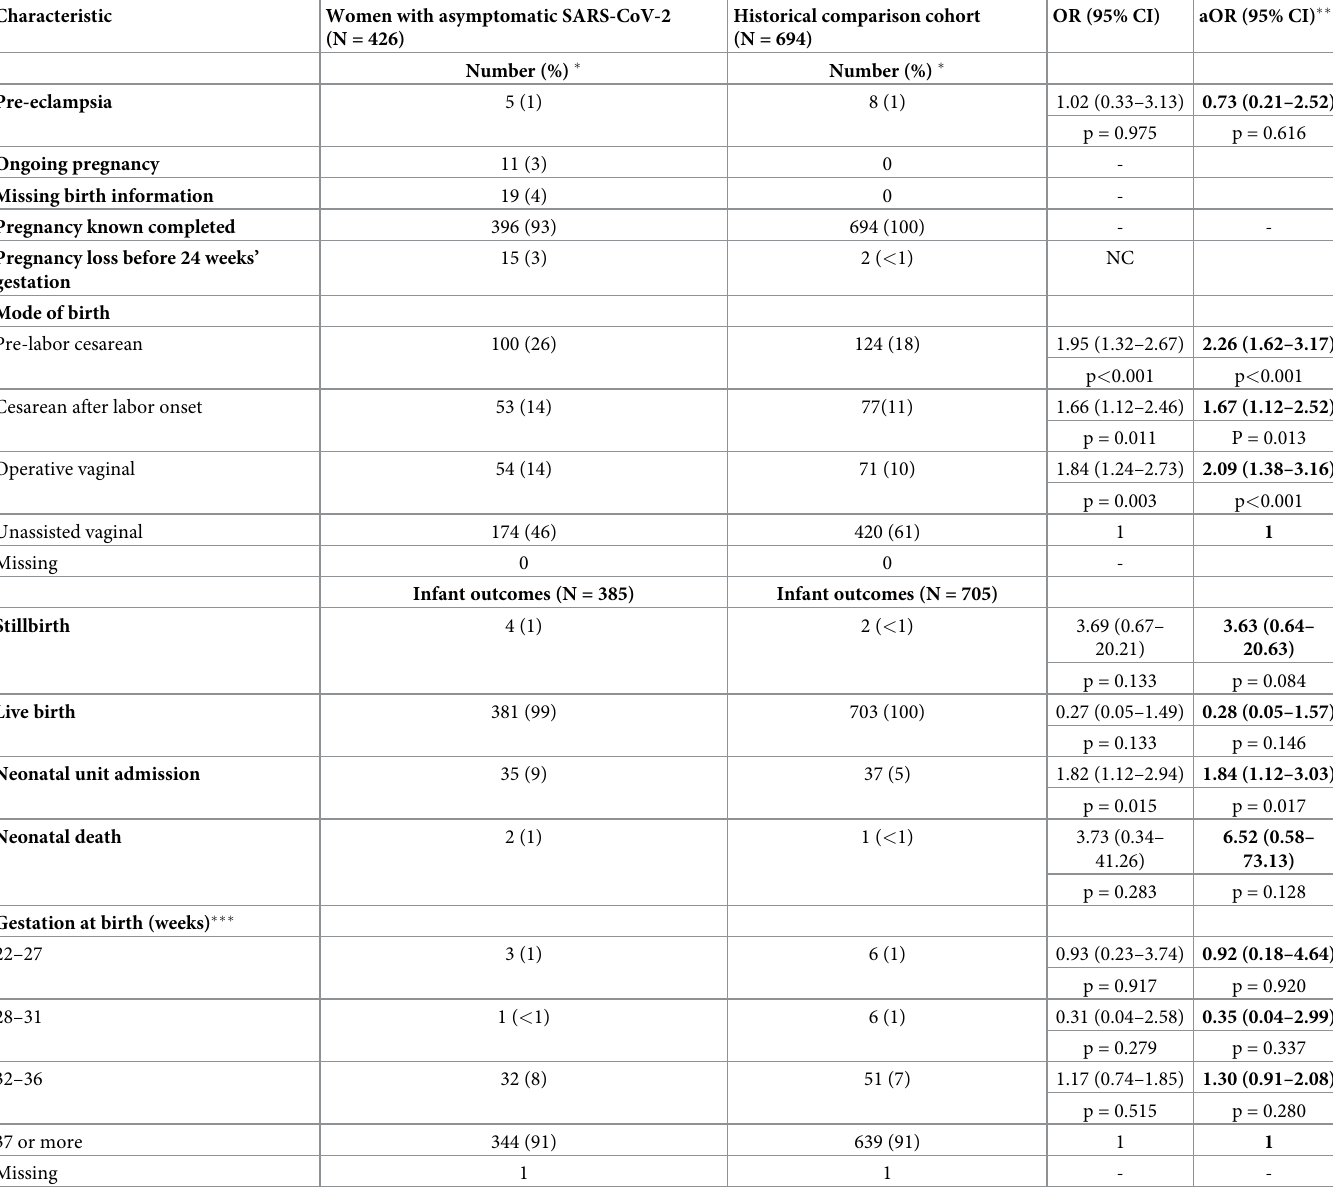
Table 5. Pregnancy and infant outcomes for pregnant women with asymptomatic confirmed SARS-CoV-2 infection hospitalized in the UK compared to a historical cohort without SARS-CoV-2 infection.